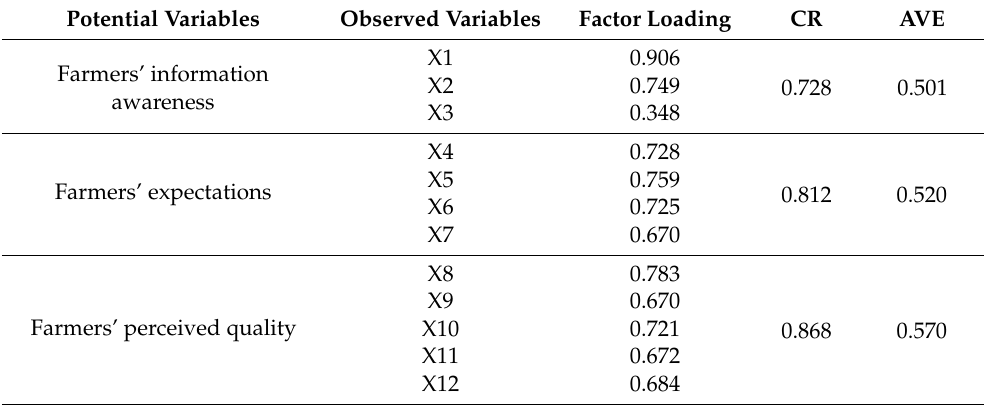
Table 6. Potential variables and item test